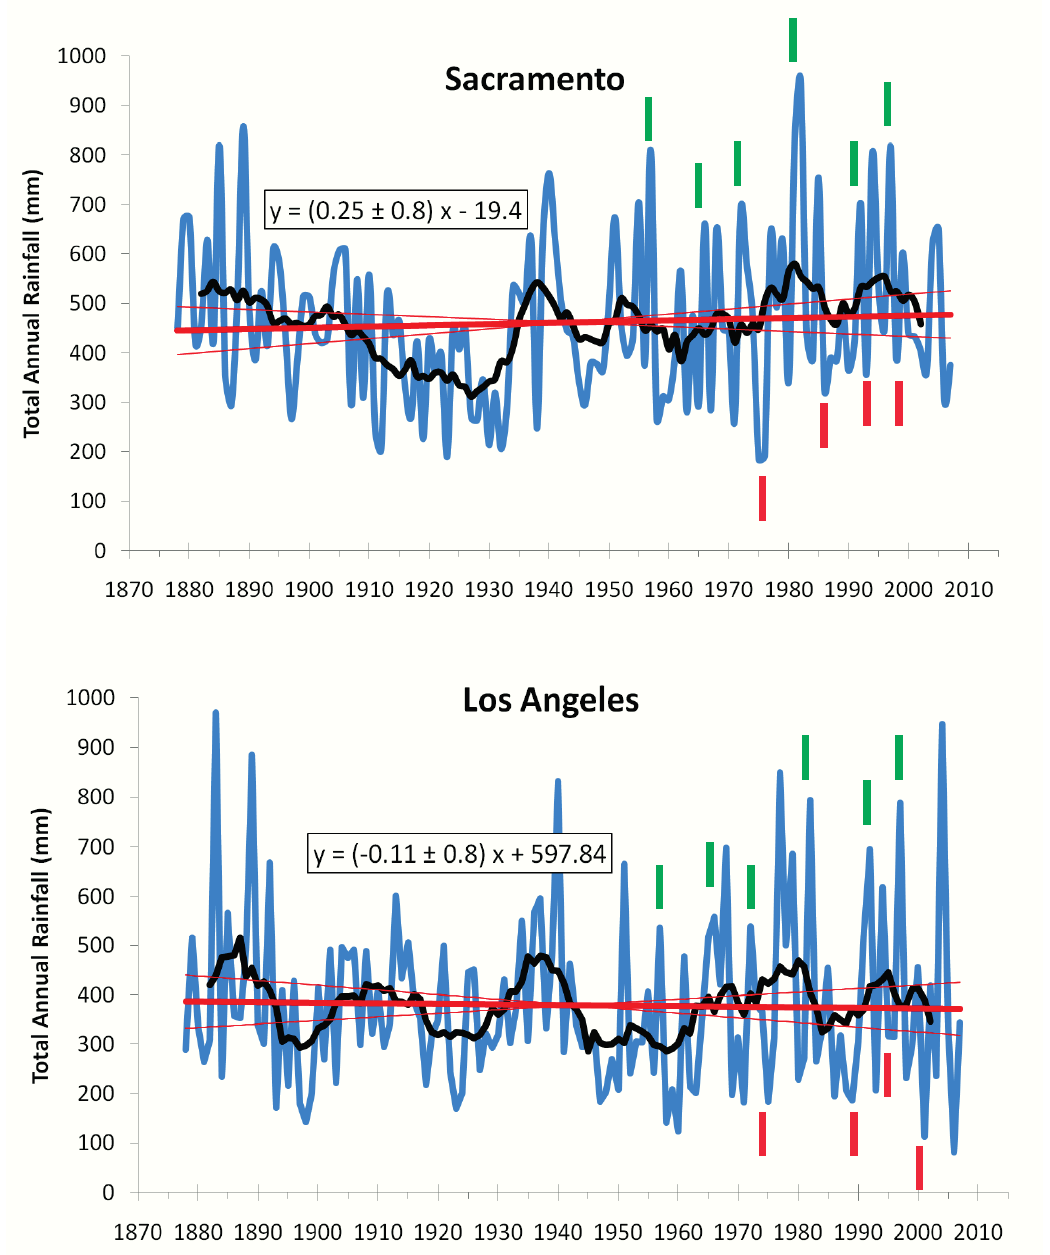
Figure 3. Time series of annual rainfall for Sacramento and Los Angeles. These plots are based on monthly rainfall records. Blue lines show annual rainfall; black lines show the 10-year running mean, and the red line shows the trend with 95% confidence limits (thinner red lines). The 10-year running mean illustrates the large amount of decadal variability present in these records, which complicates the detection of any long-term trend. Red dashes mark strong La Niña and green ones strong El Niño